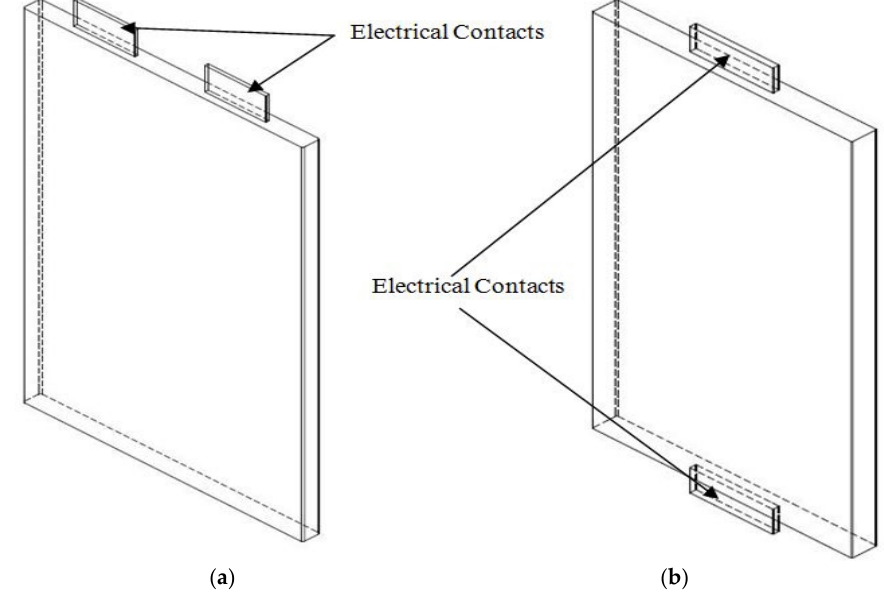
Figure 6. Position of electrical connection elements or contacts according to ISO Publicly Available Specification—ISO/PAS IEC abcd Part 1 for ( a ) high energy pouch cell and ( b ) high power pouch cell [68].